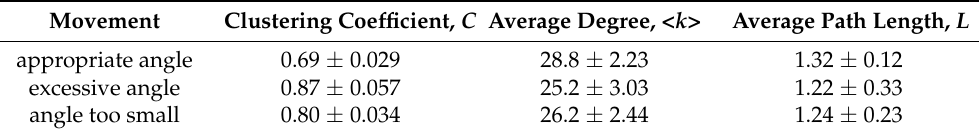
Table 1. Muscle functional network characteristics of key nodes.